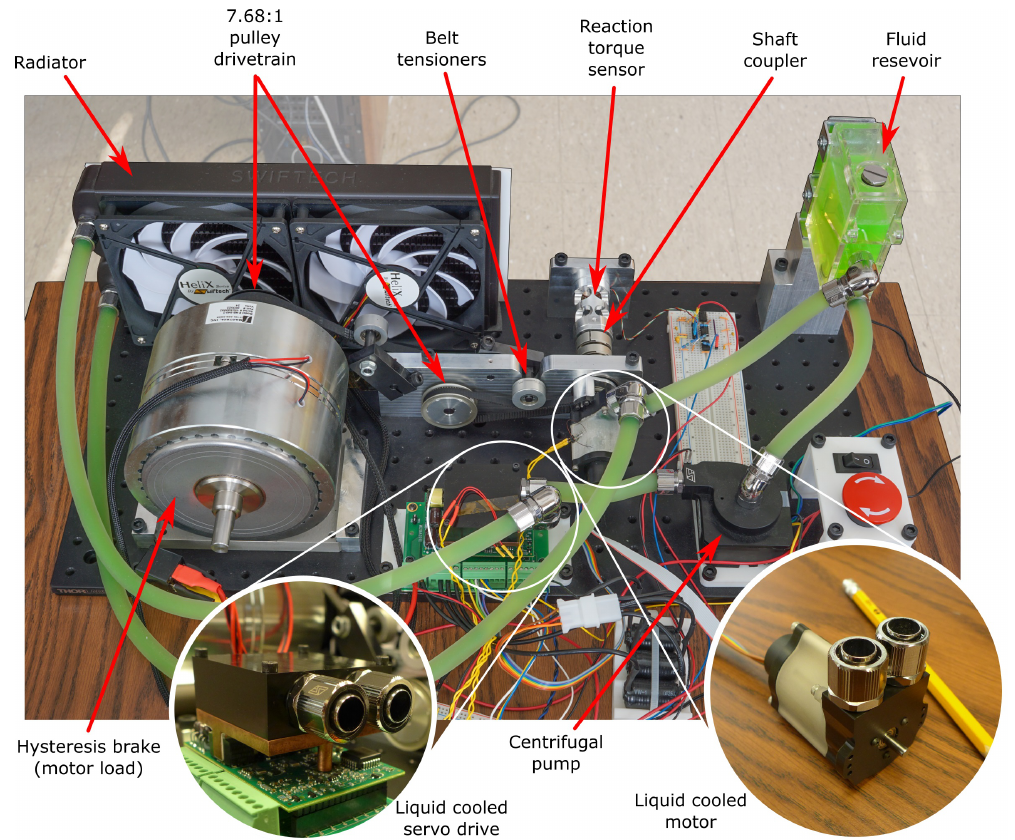
Figure 5. The motor testbed used in Section 4. This picture shows the testbed as configured for liquid cooling. For air cooling tests, a bare motor was used. This system is interfaced to a Texas Instruments TMS320F28335 microcontroller (refer to Figure 6 below).